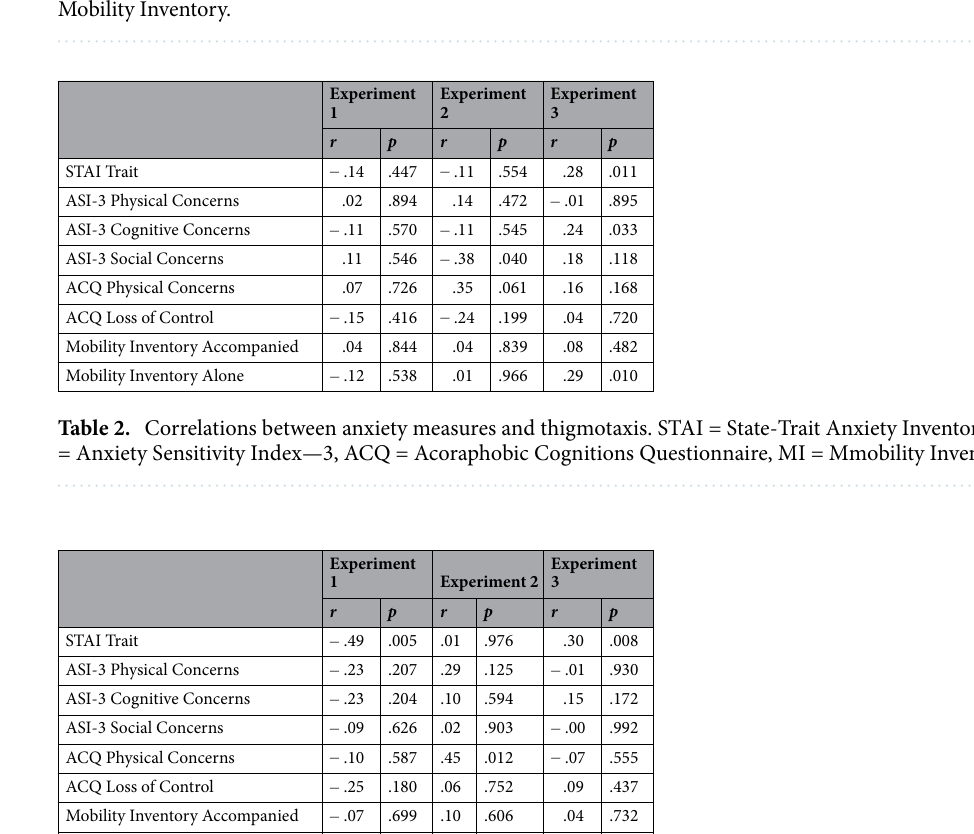
Table 1. Correlations between anxiety measures and time in outer region. STAI = State-Trait Aanxiety Inventory; ASI-3 = Anxiety Sensitivity Index—3, ACQ = Acoraphobic Cognitions Questionnaire, MI = Mobility Inventory.